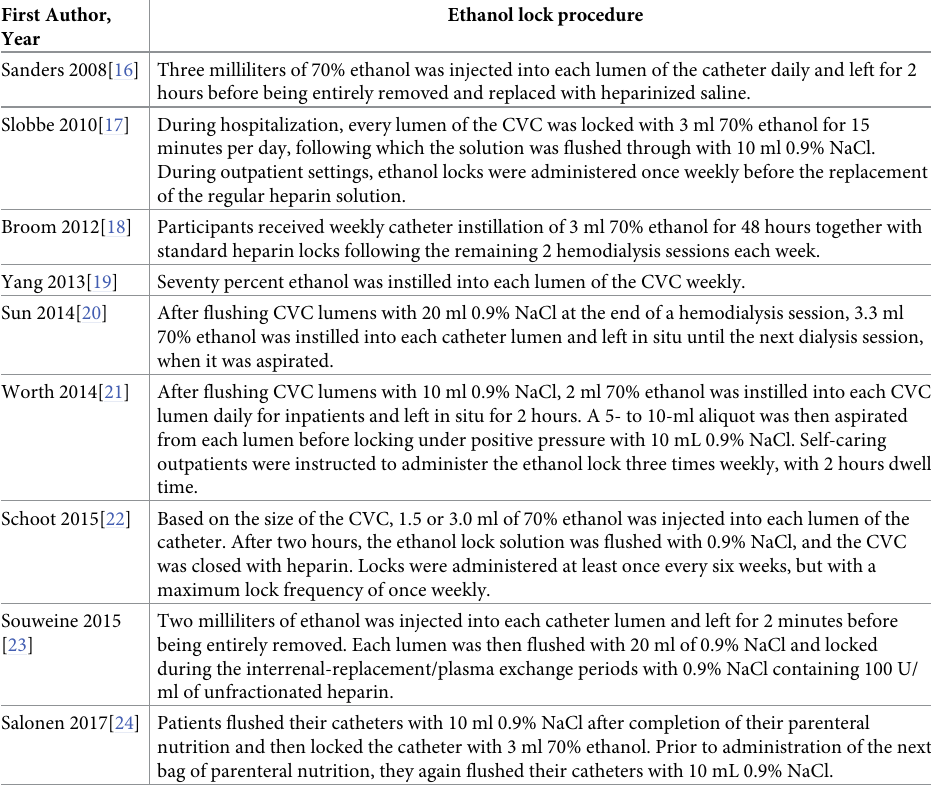
Table 2. Intervention protocols of the included